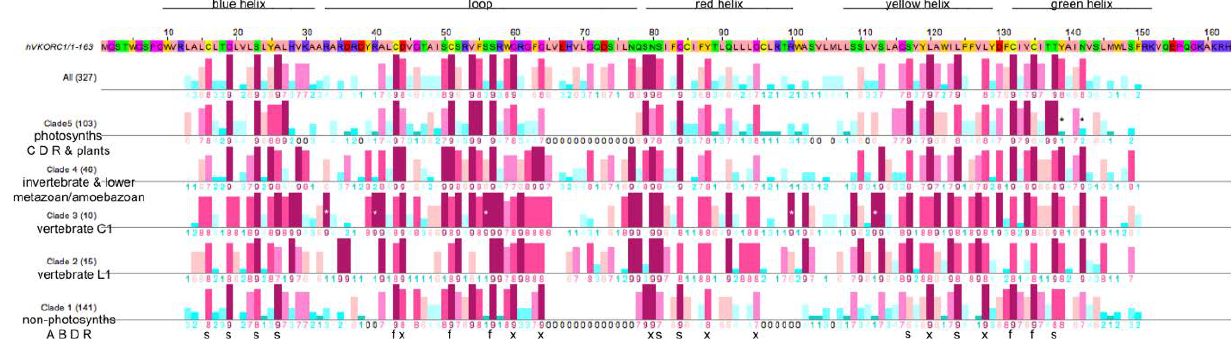
Figure 4. Comparison of Consurf conservational scoring for combined VKOR family sequences and the five individual VKOR clades. Human VKORC1 primary sequence is with relative postions of transmembrane helices (indicated using color scheme from [17]) and large loop as line segments (top); calculated Consurf conservation scores on lines below the sequence (six lines, top to bottom): All 327 VKOR sequences; Clade 5, 103 photosynthetic prokaryotes of the super-taxa C, D and R (prokaryotic super-taxa: A = Actinobacteria, B = Bacilli an related, C = Clostridia and related, D = double membrane Gram-negative bacteria, R = Archaea [56]); Clade 4, 46 invertebrates, lower metazoans, euglenozoans and mycetozoans; Clade 3, 10 vertebrate VKORC1 orthologs; Clade 2, 15 vertebrate VKORC1L1 orthologs; Clade 1, 141 non-photosynthetic prokaryotes of the super-taxa A, B, D and R. Darker red bars indicate greater positional conservation, darker blue bars indicate greater positional non-conservation (conservation scores below bars; lowest score 1 to highest score 9). Systematically absent from the prokaryotic sequences (clades 1 and 5) indicated with black zeros in place of Consurf scores. Fully conserved vertebrate VKORC1 residues (white asterisks superimposed upon dark red bars); Clade 5-specific absences of conserved Tyr139 and Asn142 (black asterisks above dark blue bars, human VKORC1 numbering). Letters and symbols (bottom) for positions highly conserved across all five major clades: s = structural residue contributing to helix-helix packing interactions; f = residues full conserved across all species and presumed to be catalytically active (Cys43, Cys51, Ser57, Cys132, Cys135); x = residues that are highly conserved, but presently lacking assignment as to structural or functional importance.